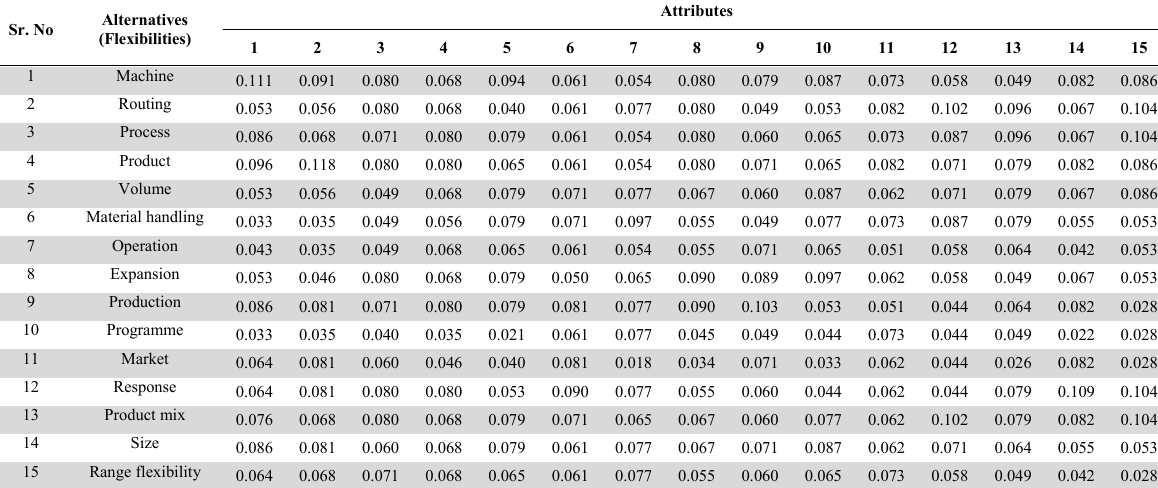
Normalized decision matrix Sr. No